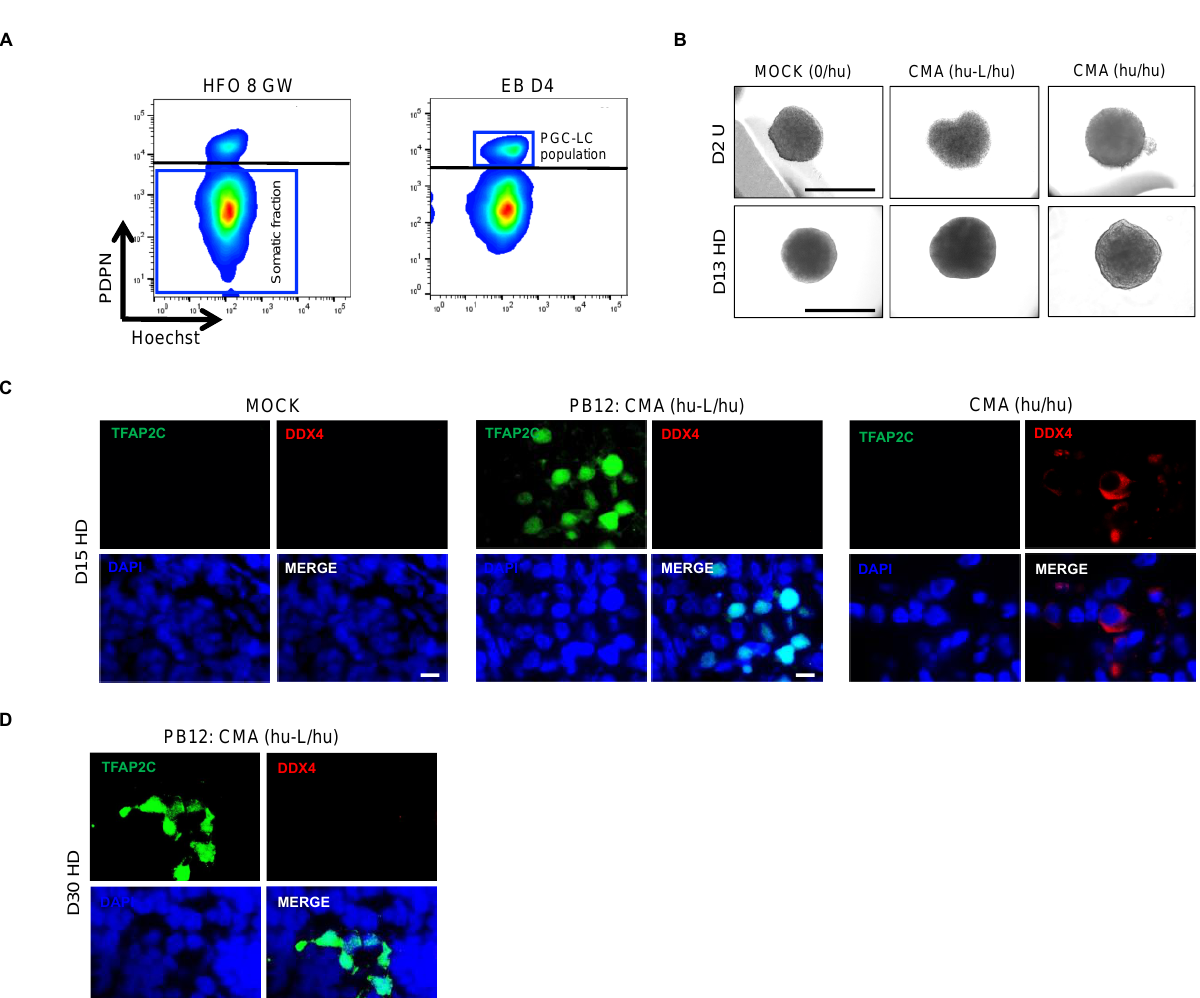
Figure 4. In vitro assessment of early hPGC-LC development when cultured in a somatic environment of human fetal ovary. ( A ) Cytometry plots show the somatic and germ cell populations from a human fetal ovary (plot on the left) and the PGC-LC fraction obtained from day 4 EBs (plot on the right). The day 4 EBs PDPN-positive cells were mixed with the ovarian PDPN-negative cells at a ratio of 2:8 ( B ) Images of day 2 (top row) and day 15 (bottom row) of re-aggregated ovaries in the absence (MOCK) or presence of the PDPN-positive human PGC-LCs [CMA (hu-L/hu)]. A positive control was used by mixing authentic PDPN-positive hPGCs with the ovarian somatic cells popu- lation [CMA (hu/hu)]. Scale bar, 500 µm. ( C ) Immunofluorescence analyses for the absence or pres- ence of TFAP2C and DDX4 proteins in MOCK, CMA (hu-L/hu) and CMA (hu/hu) conditions at day 15 of culture. ( D ) Immunofluorescence analyses for the absence or presence of TFAP2C and DDX4 proteins CMA (hu-L/hu) condition at day 30 of culture. CMA hu/hu: Cell Mixture Aggregate (hu- man PGCs/human somatic cells); CMA hu-L/hu: Cell Mixture Aggregate (human PGC- Like Cells/human somatic cells); D15 HD: Day 13 from Hanging Drop; D30 HD: Day 28 from Hanging Drop; D2 U: Day 2 from U-bottom low adherence 96 well plate; EB D4: Embryoid Body at Day 4; HFO 8 GW: Human Fetal Ovary of 8 Gestational Week; MOCK (0/hu): 8 gestational week human ovarian somatic cells. 3.5. The Somatic Environment of Mouse Fetal Ovary Is Unpermissive for hPGC-LC Maturation and Meiotic Onset Unlike in humans, in mouse fetal ovaries, all germ cells undergo meiosis in a syn- chronous manner with no maintenance of undifferentiated PGCs [4,7,30]; this may thus represent a niche more permissive to meiotic entry. To assess if the mouse somatic envi- ronment allows further differentiation of hPGC-LCs, day 4 EBs and mouse fetal ovaries (MFO) were processed as described in Figure 5A. Pou5f1-GFP mice that specifically